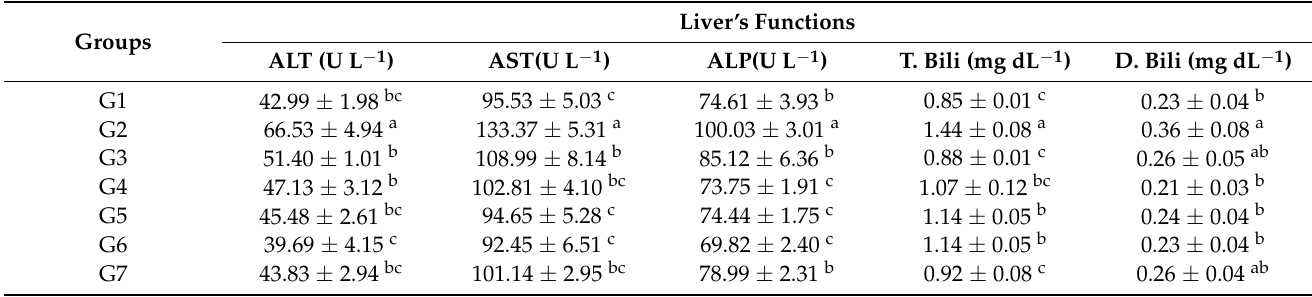
Table 5. Effect of probiotic-enriched FCM combined with S. officinalis on liver functions in STZ- induced diabetes in rats.